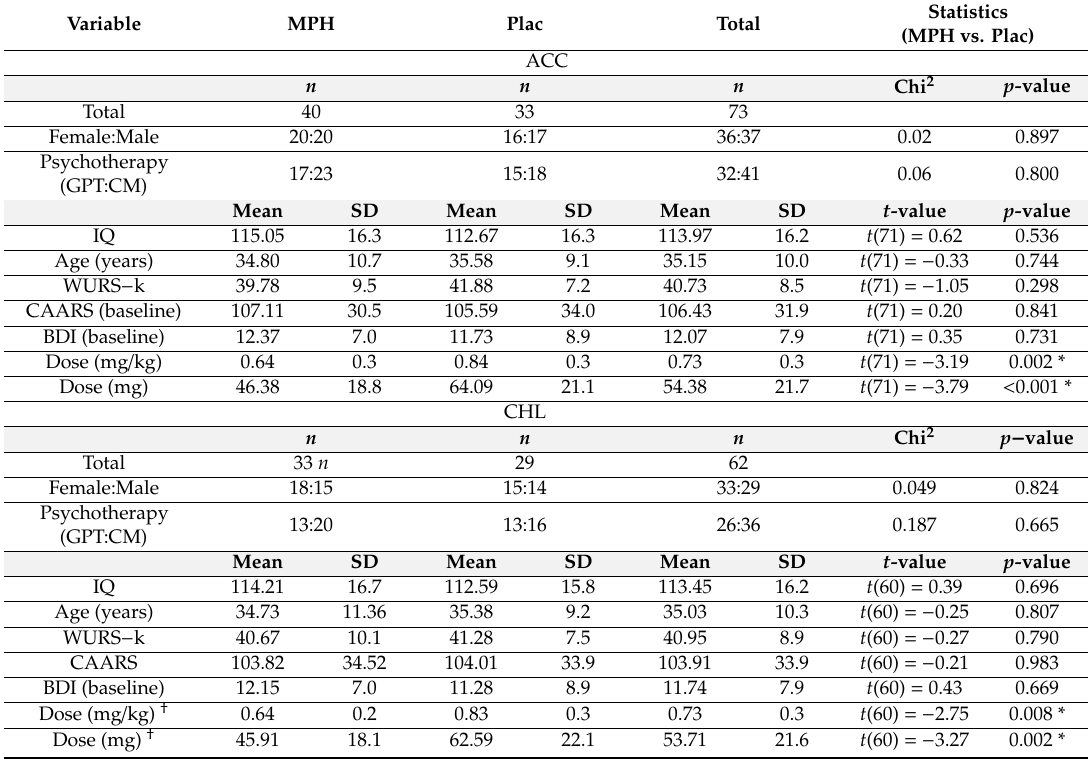
Table 2. Comparison of demographic and psychometric data of methylphenidate (MPH) versus placebo (Plac) cohorts in the anterior cingulate cortex (ACC) and left cerebellar (CHL)